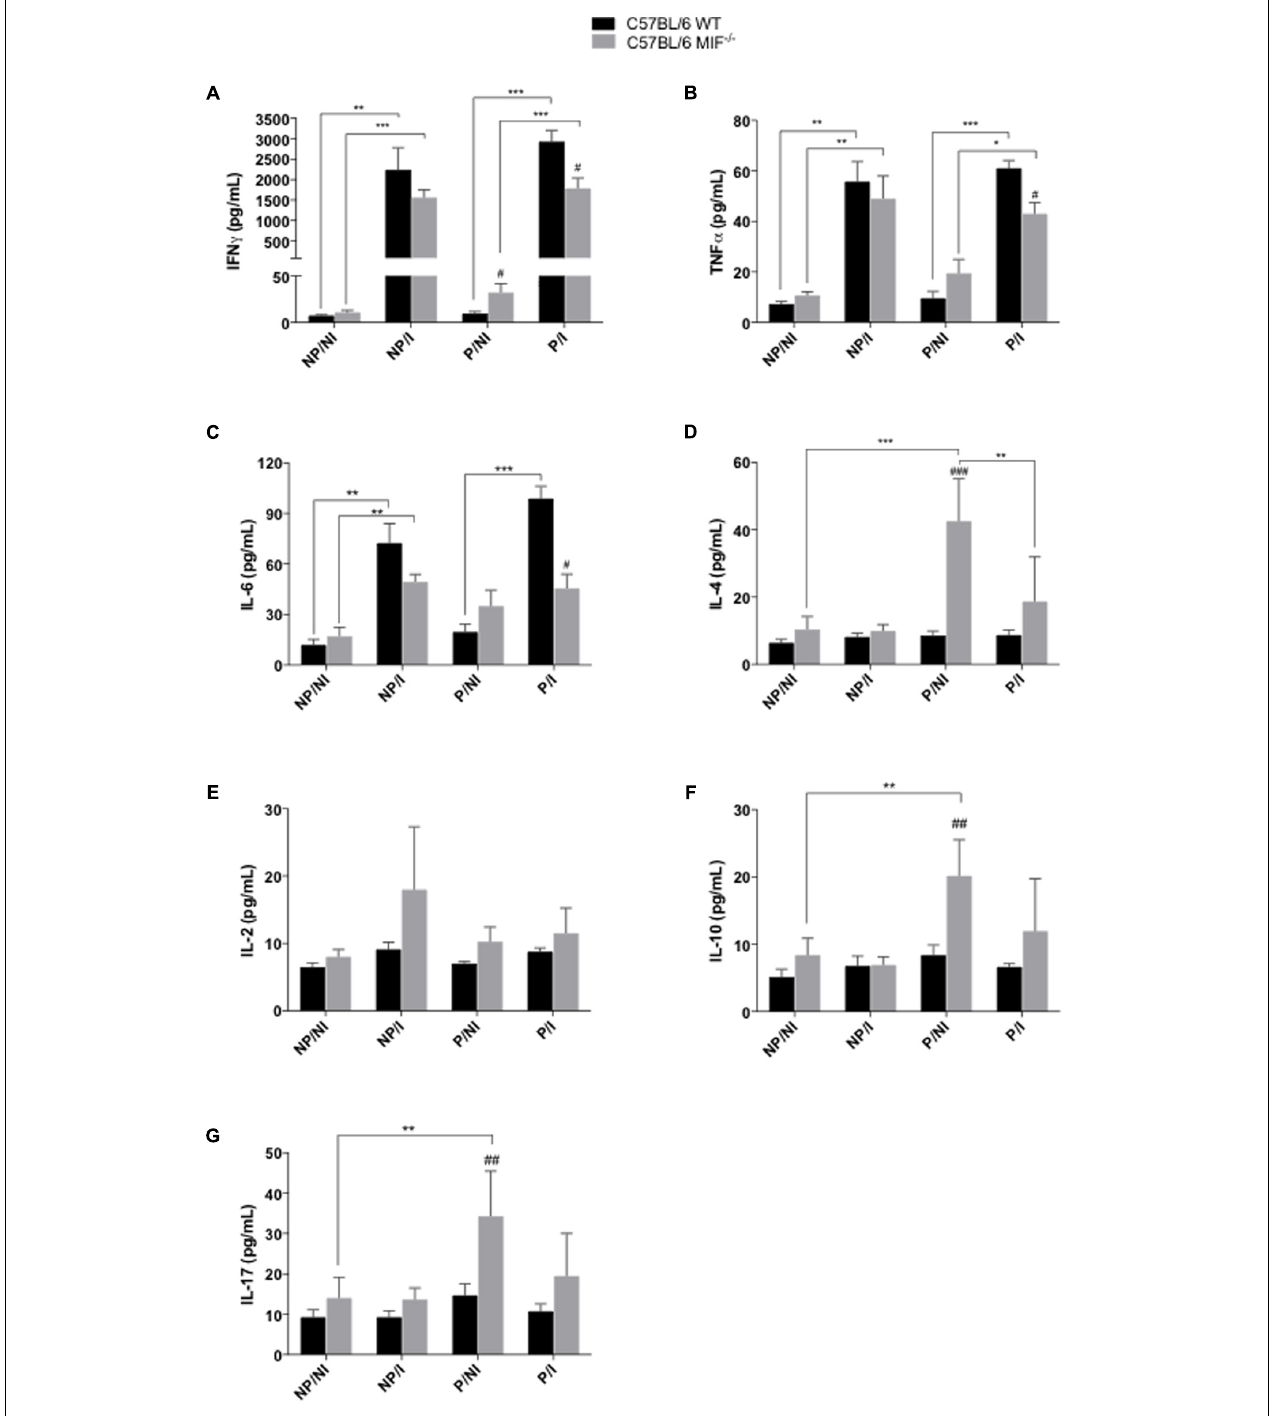
FIGURE 3 | Cytometric bead assay (CBA) for cytokine measurements in serum samples of pregnant and non-pregnant C57BL/6 MIF − / − and C57BL/6 WT mice orally infected by Toxoplasma gondii. Serum samples were collected within 8 days of infection/pregnancy. Non-infected pregnant and non-pregnant mice were used as controls. Data indicate levels of IFN- γ (A) , TNF- α (B) , IL-6 (C) , IL-4 (D) , IL-2 (E) , IL-10 (F) , and IL-17 (G) , presented as mean and SEM from serum samples of five animals per group and are expressed in pg/mL. # Significant differences between MIF − / − and WT mice in the same experimental condition ( # P < 0.05, ## P < 0.01, ### P < 0.001). ∗ Comparisons between multiple experimental conditions within the same group (NP/NI, non-pregnant/non-infected; NP/I, non-pregnant/infected; P/NI, pregnant/non-infected; P/I, pregnant/infected) are indicated by bars ( ∗ P < 0.05; ∗∗ P < 0.01; ∗∗∗ P < 0.001). Data were compared by the Kruskal–Wallis test and Dunn multiple comparison